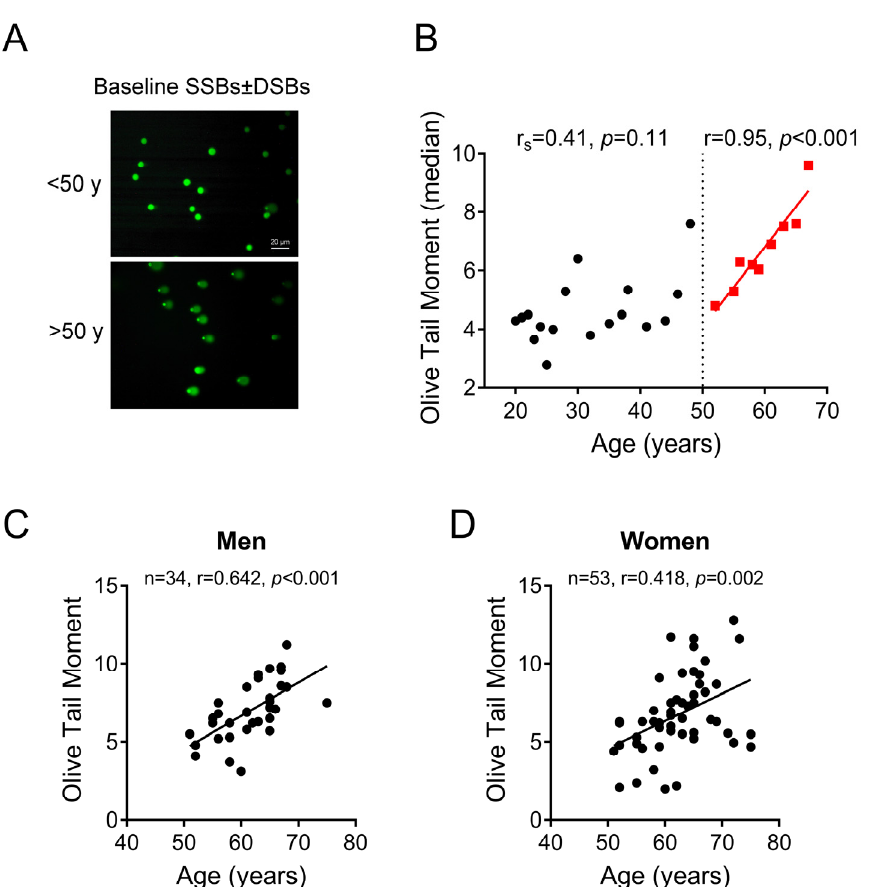
Figure 1. Endogenous SSBs ± DSBs in PBMCs. ( A ) Representative alkaline comet assay images of untreated PBMCs from a healthy individual under the age of 50 years and an individual over the age of 50 years (scale bar: 20 µ m). ( B ) Correlation of DNA damage measured by alkaline comet assay with age in 243 apparently healthy humans (men and women). To reduce variance, we calculated the median OTM value per each age including only those ages with at least 4 observations. ( C , D ) Correlation of DNA damage measured by alkaline comet assay with age in 34 men older than 50 years ( C ), and in 53 women older than 50 years ( D ). Correlation coefficients were calculated using Pearson’s test for individuals aged ≥ 50 years and Spearman’s rank correlation coefficient (r s ) for individuals younger than 50 years due to non-normal data distribution.